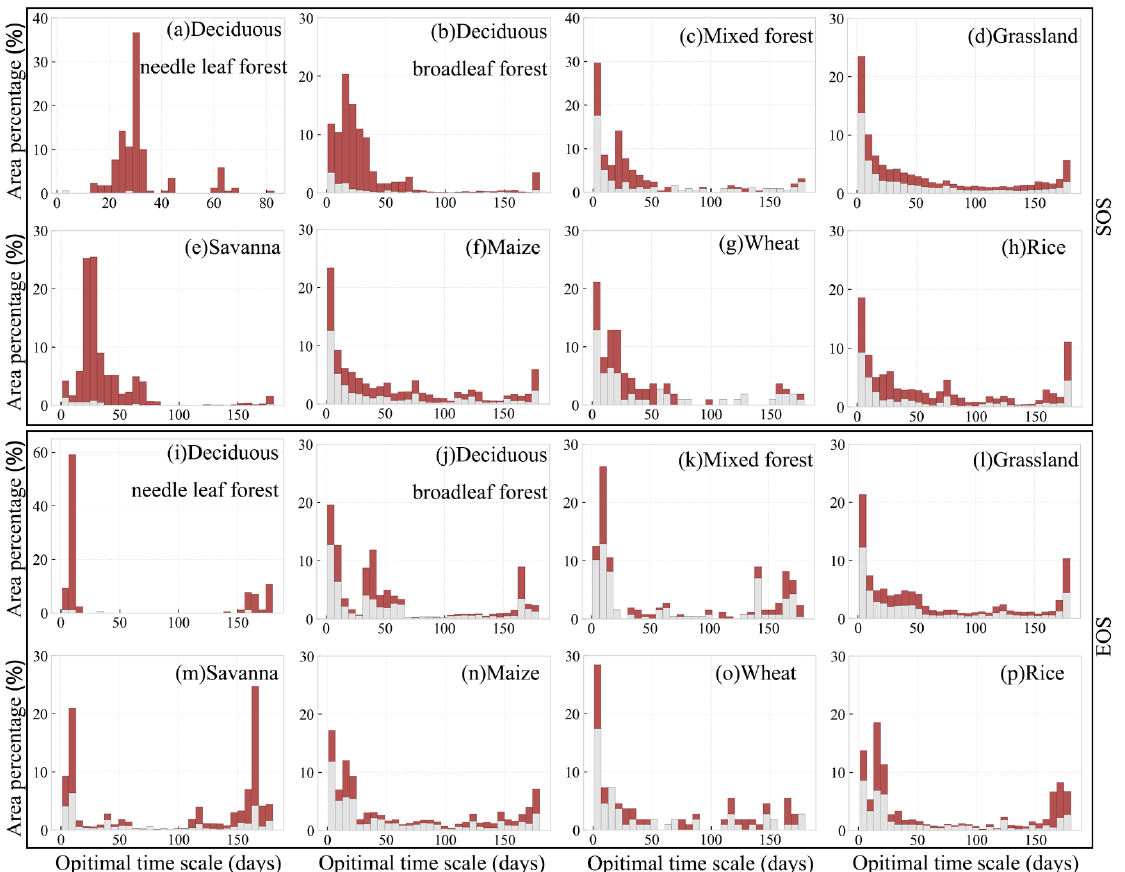
Figure 10. ( a – h ) Histograms of the optimal time scale of different land-use types for SOS vs. preseason temperature, and ( i – p ) for EOS vs. preseason temperature. Red part means p -value < 0.05, while gray means p -value ≥ 0.05.